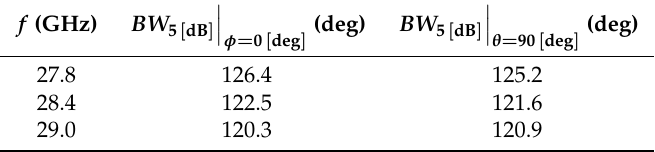
(cid:104) (cid:105) ( p ) ( p ) = [ 27.8, 29.0 ] (GHz), f , f max min